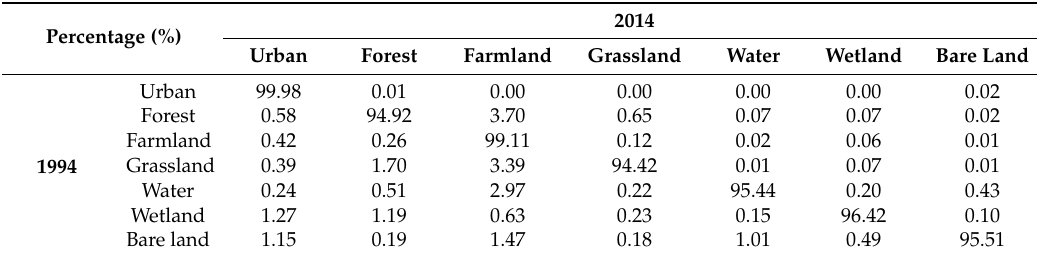
Table 5. Annual transition probability (%) from 1994 to 2014.